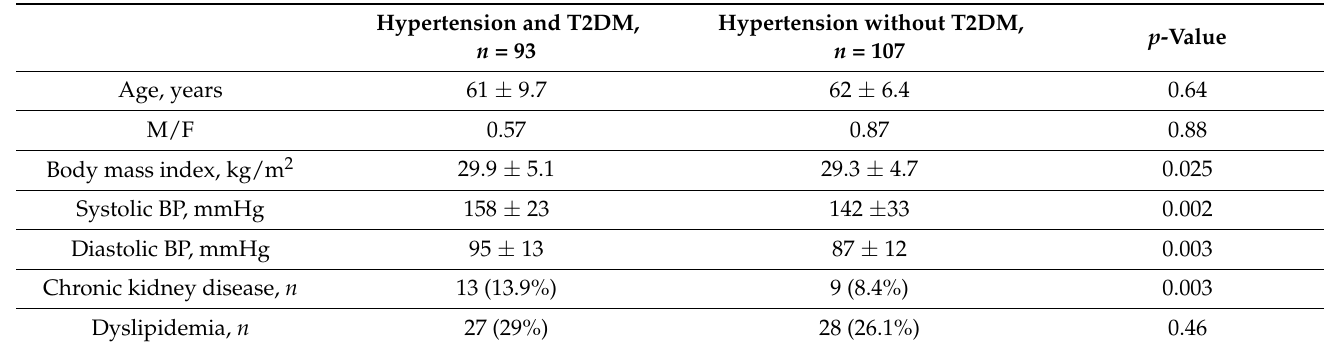
Table 1. General characteristics of the study population.